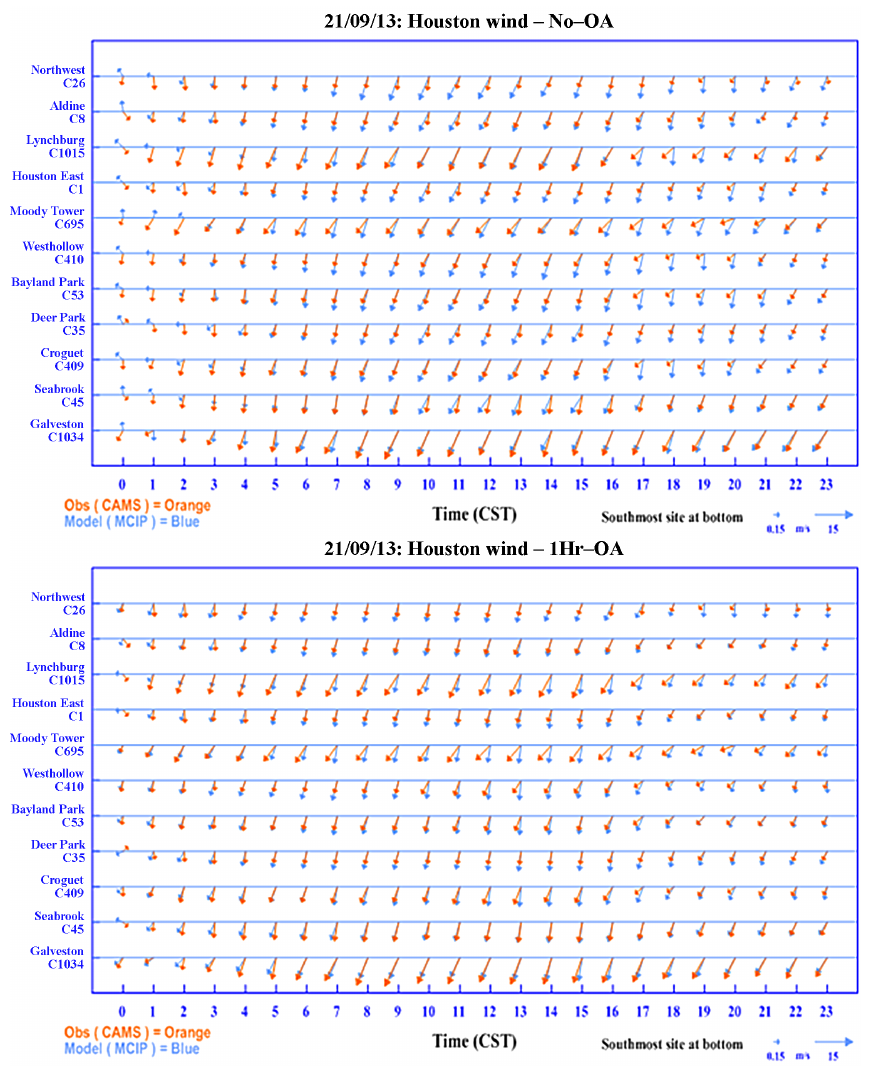
Figure 7. Hourly model (blue) and CAMS (orange) winds at 11 sites on 21 September: No-OA (top panel) and 1Hr-OA (bottom panel). The 1Hr-OA case is better at 00:00 to 02:00CST and 17:00 to